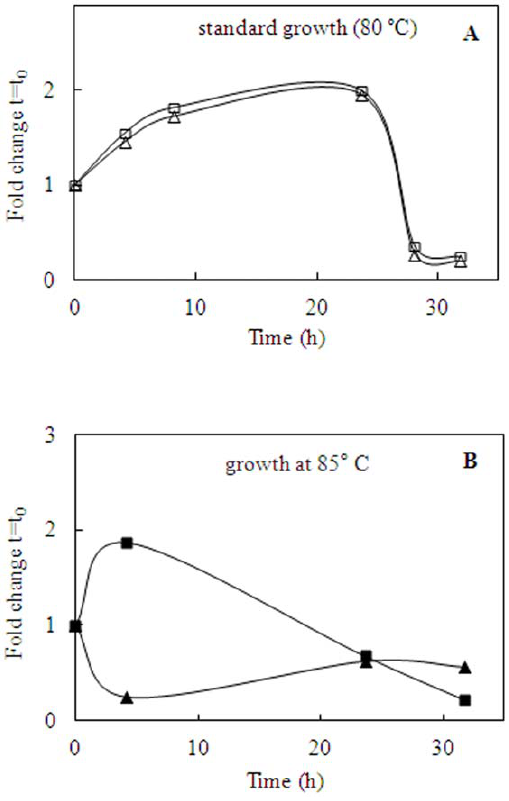
Figure 5. Transcriptional analysis under thermal stress. ( A–B ) Comparisons of apeh Ss (squares) and apeh-3 Ss (triangles) fold changes of gene transcriptions under standard ( % ; n ) or thermal stress ( & ; m ) conditions, normalized respect to the expression level at t=t 0 of 23S gene.